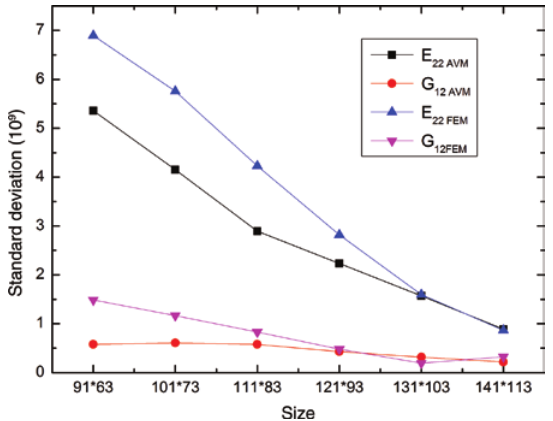
Figure 12: STD for different RVE sizes, obtained by the volume average method and the finite element method.